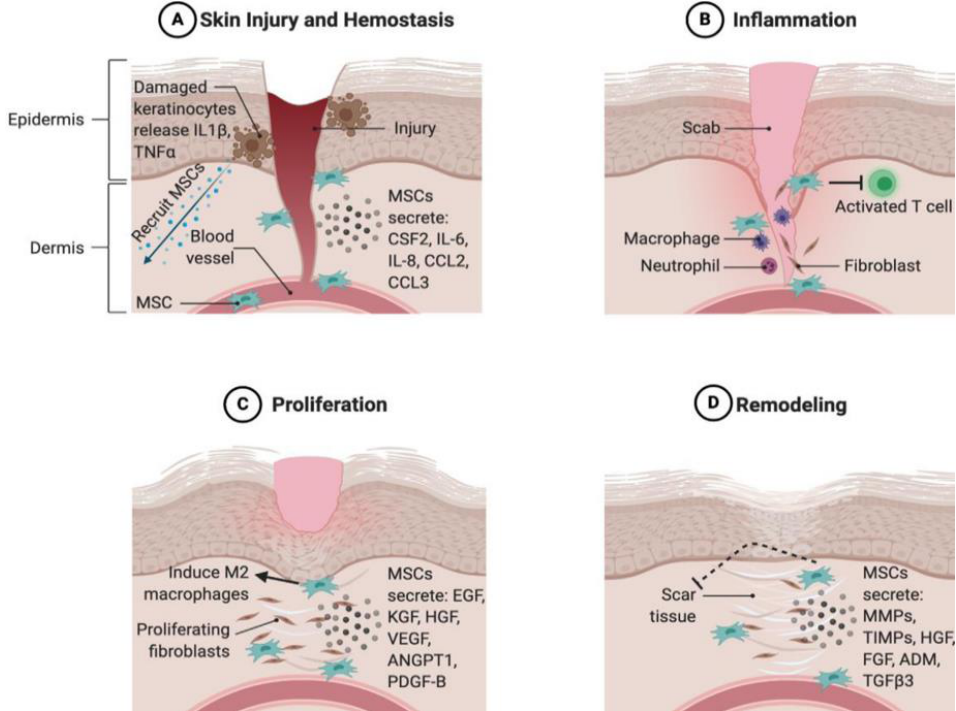
Figure 1. MSC recruitment to wounded skin and the inflammatory phase, and known and potential roles of MSCs in each phase of wound healing. ( A ) Skin injury and hemostasis. ( B ) Inflammation. ( C ) Proliferation. ( D ) Remodeling. Image reproduced with permission from Riedl et al. [44], Copyright 2021, Elsevier B.V. Ltd.